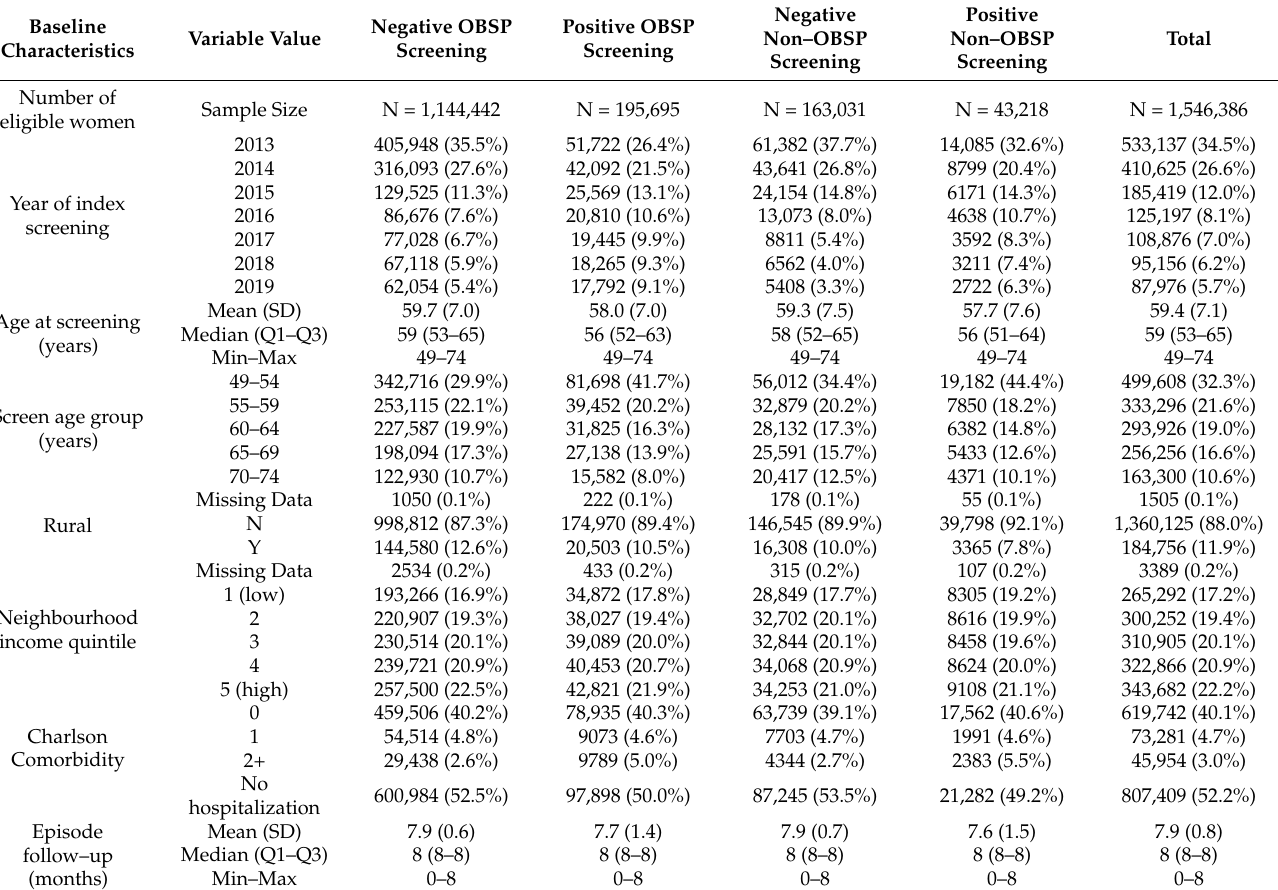
Table 1. Characteristics of women aged 49–74 in Ontario from 1 January 2013 to 31 December 2019, by screening